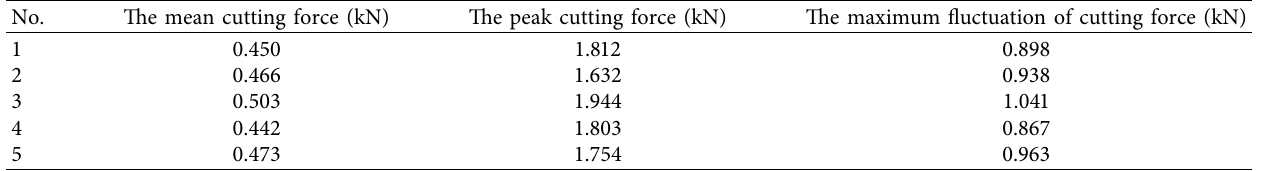
Table 6: Statistics of cutting force with different face cleat